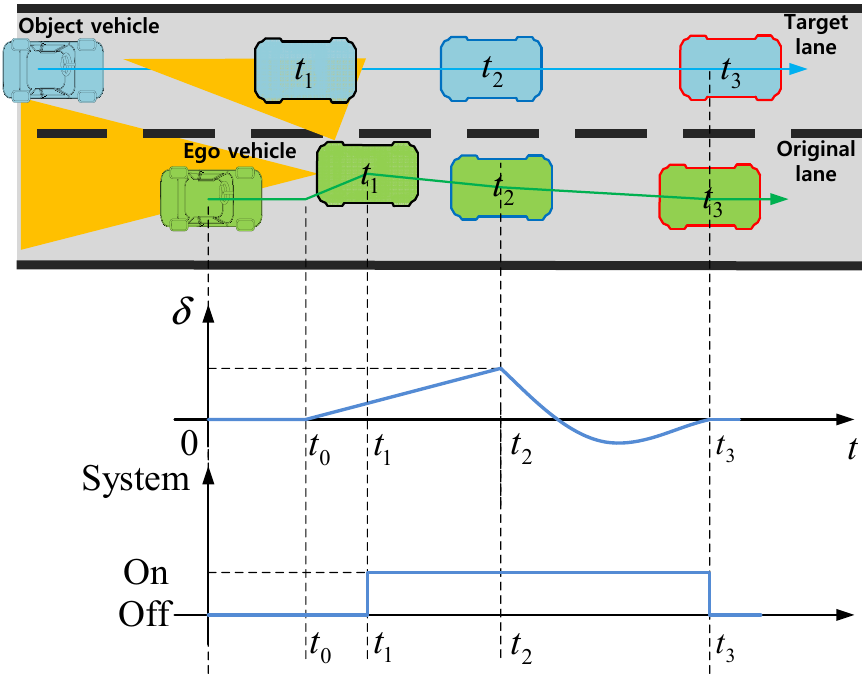
Figure 4. Strategy of the lateral control for the avoidance of the side